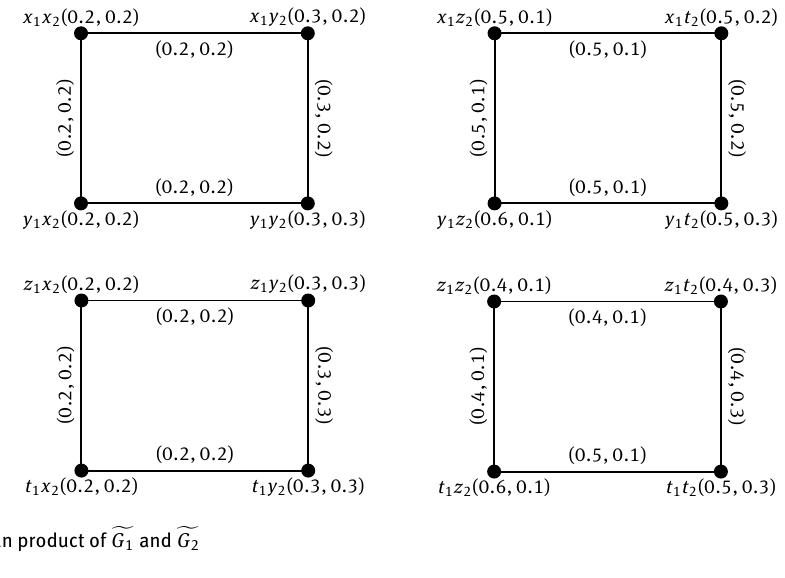
Figure 5: Cartesian product of (cid:102) G 1 and (cid:102) G